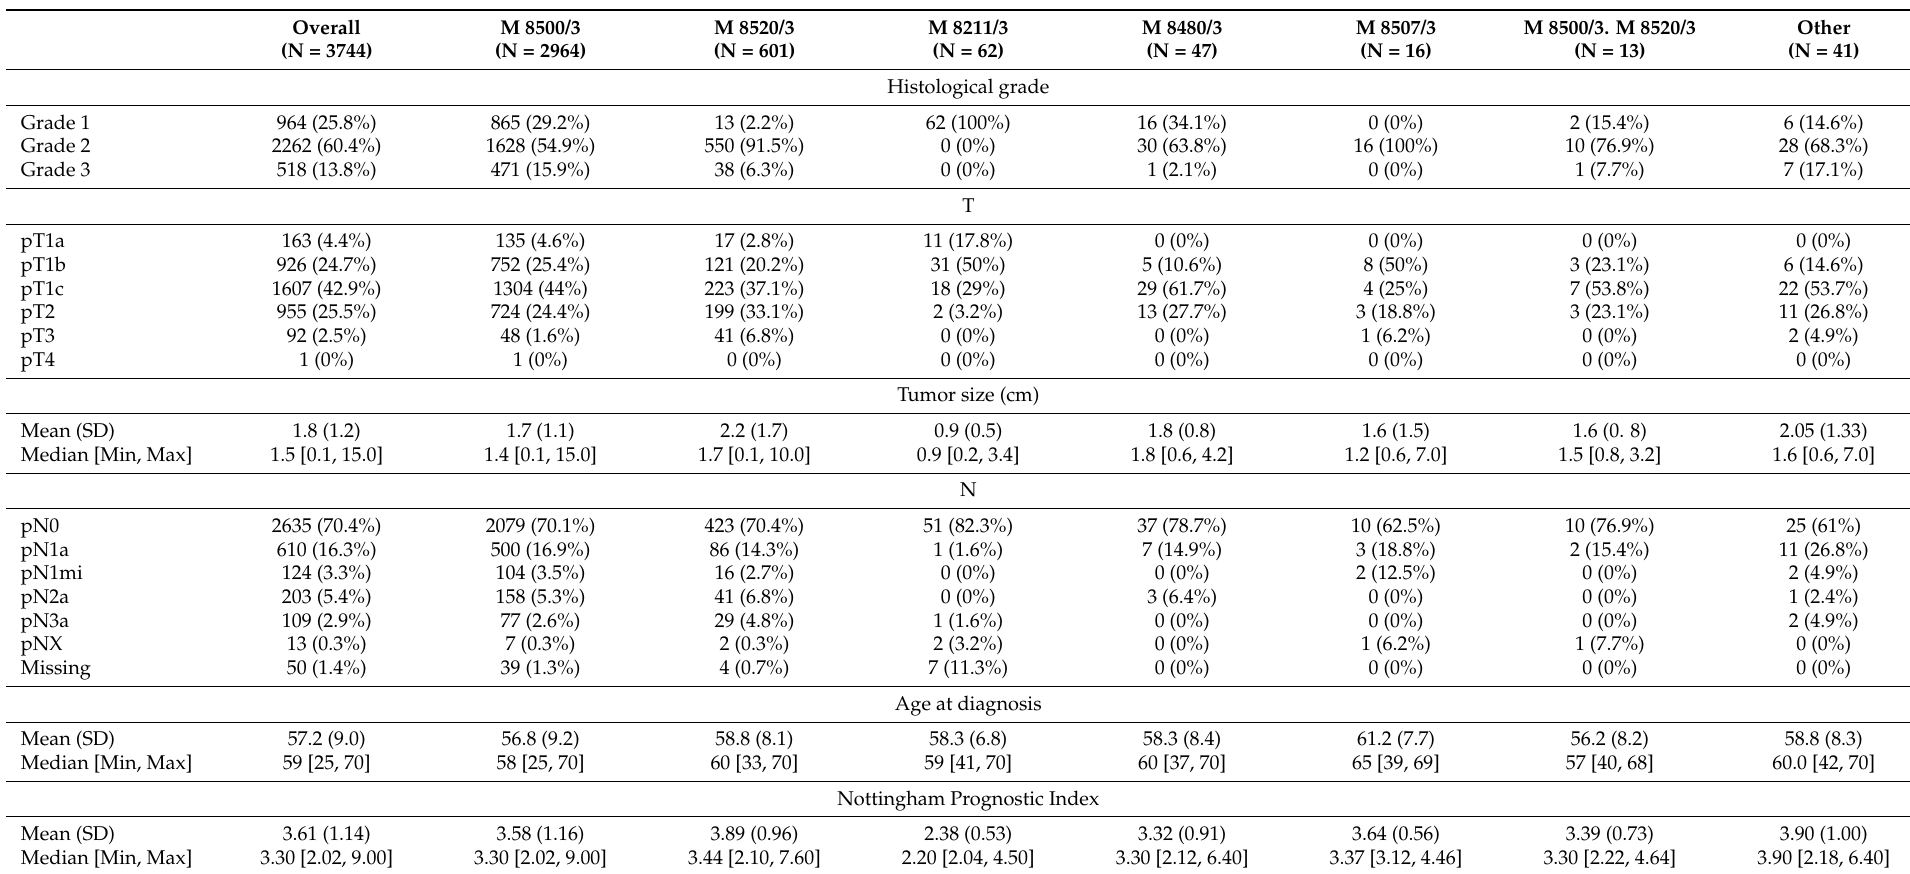
Table 2. Distribution of patients and tumor characteristics among unifocal invasive breast cancer cases with additional filters (ER+, Her2-, ≤ 70) and different WHO tumor classifications (=subtypes). Classifications with 10 or less expressions were combined into one category